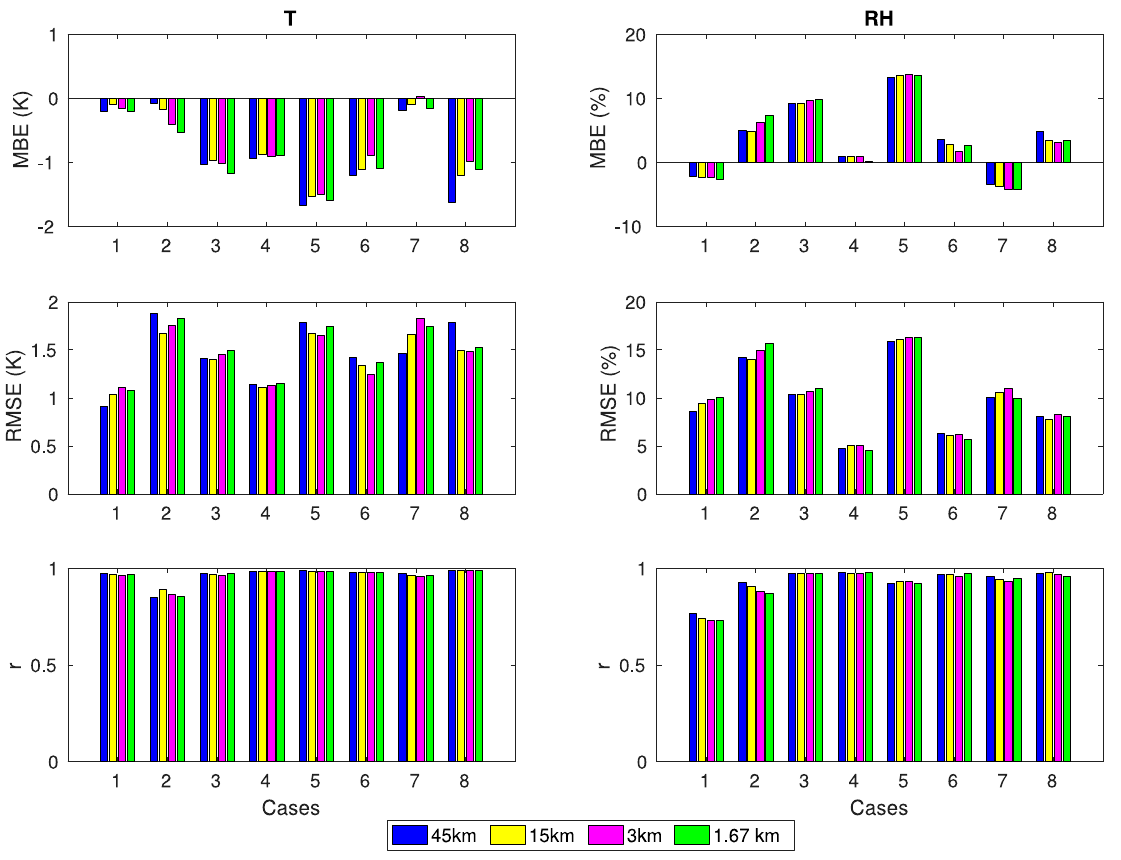
Figure 5. Evaluation statistics MBE ( top ), RMSE ( middle ), and r ( bottom ) for surface variables temperature (T, left ) and relative humidity (RH, right ) for intermittent (1–4) and clear cases (5–8) simulated with WRF-Solar.